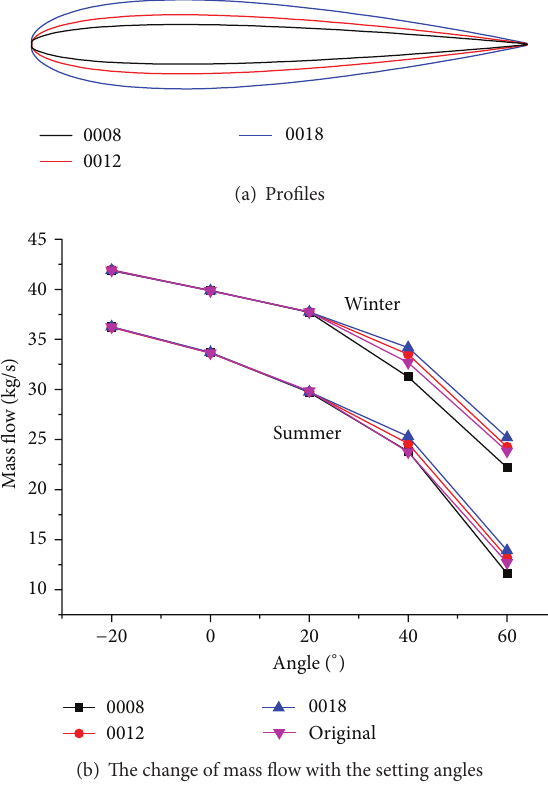
(b) The change of mass flow with the setting angles Figure 10: Straight guide vanes with different thickness.